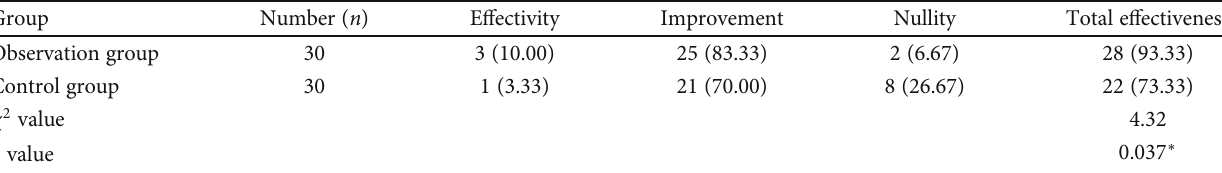
Table 1: Statistical analysis of the treatment e ff ect of the two groups of patients ( n , %).